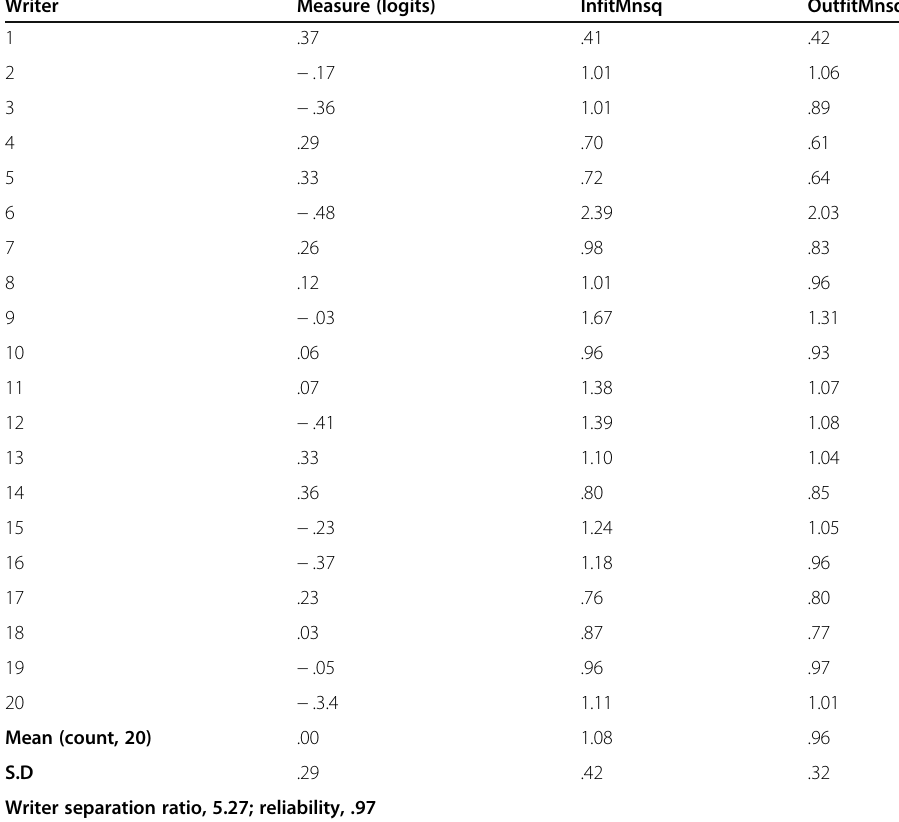
Table 3 Writer measurement report — whole